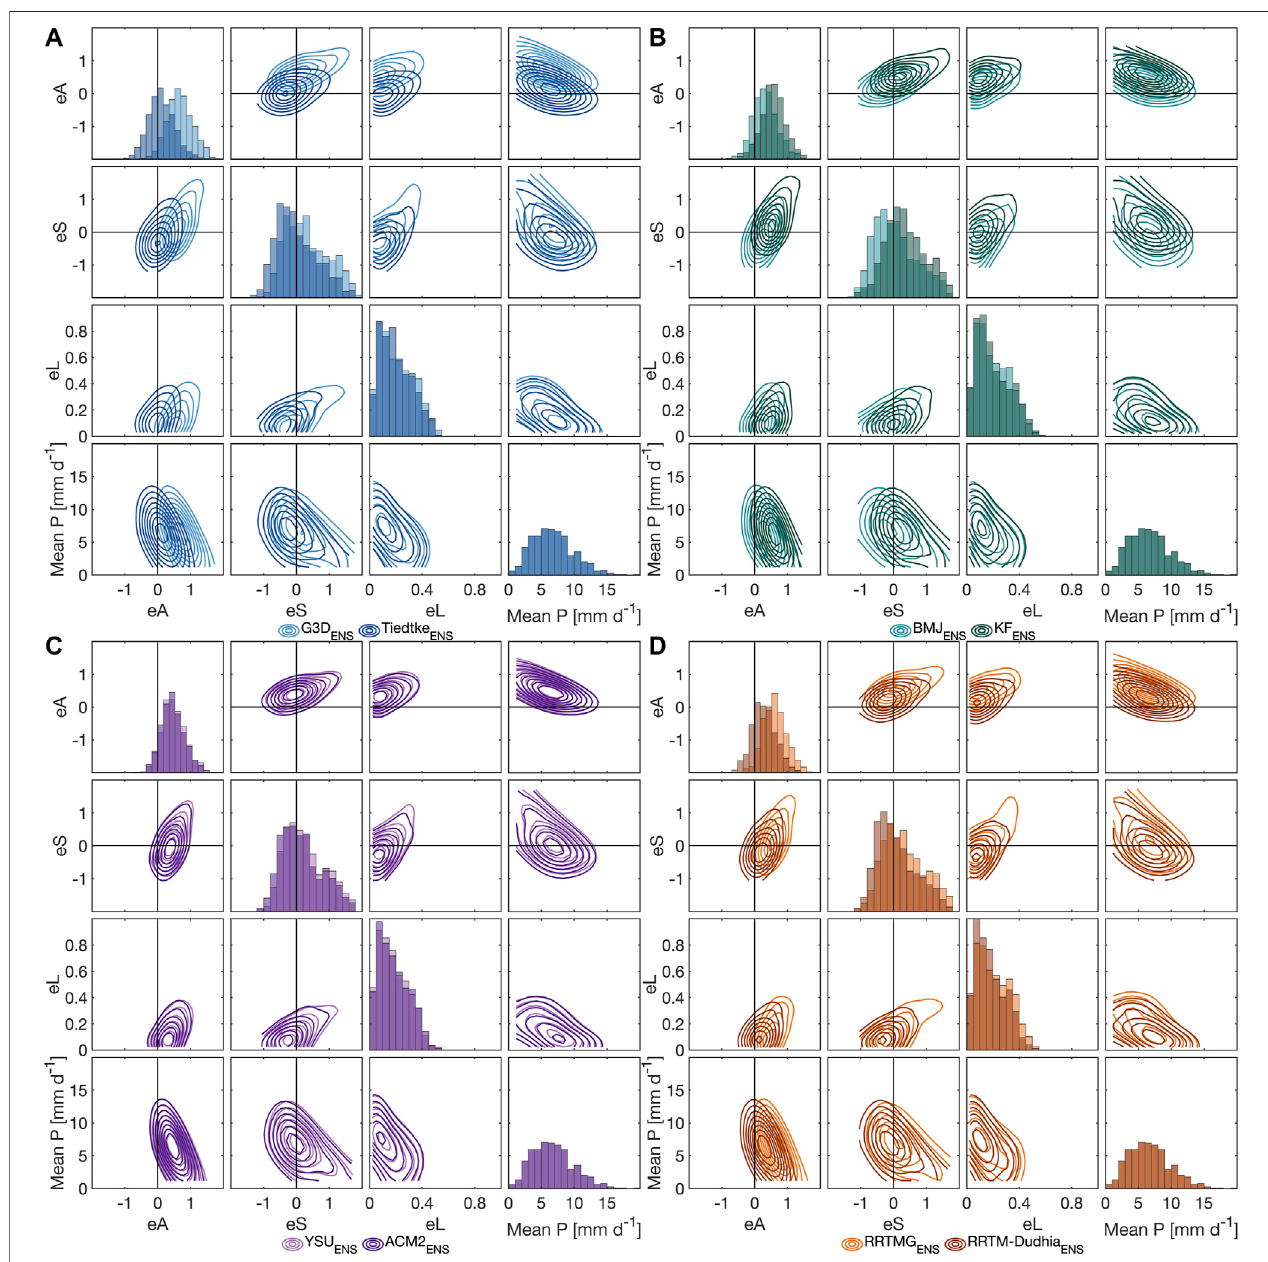
FIGURE10| EnsembleStructure-Amplitude-Location(eSAL)analysisforEP9withrespecttoCHIRPSforthephysicalparameterizationsub-ensemblesof (A) G3D and Tiedtke (B) BMJ and KF (C) YSU and ACM2, and (D) RRTMG and RRTM-Dudhia. For each physics sub-ensemble, eA , eS , eL and the reference domain average precipitation (Mean P) are juxtaposed in density contour plots of daily values from Jul 2006 till Jun 2008. The diagonal shows the probability histograms of eA , eS , eL of the respective physics ensemble and of the reference domain average precipitation (Mean P). When the transparently colored probability histograms of eA , eS , or eL overlap, darker colors are produced. As all different parameterization groups use CHIRPS as reference, histograms of reference mean P always